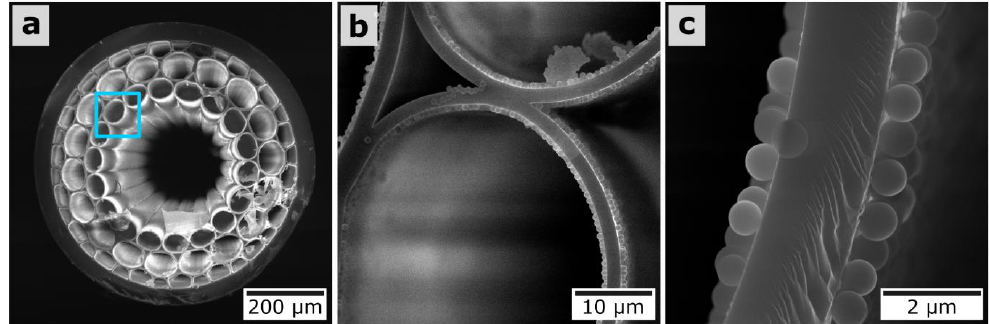
Figure 7. SEM images of ( a ) the MOW end face and ( b , c ) capillaries with a layer of 900-nm silica particles.